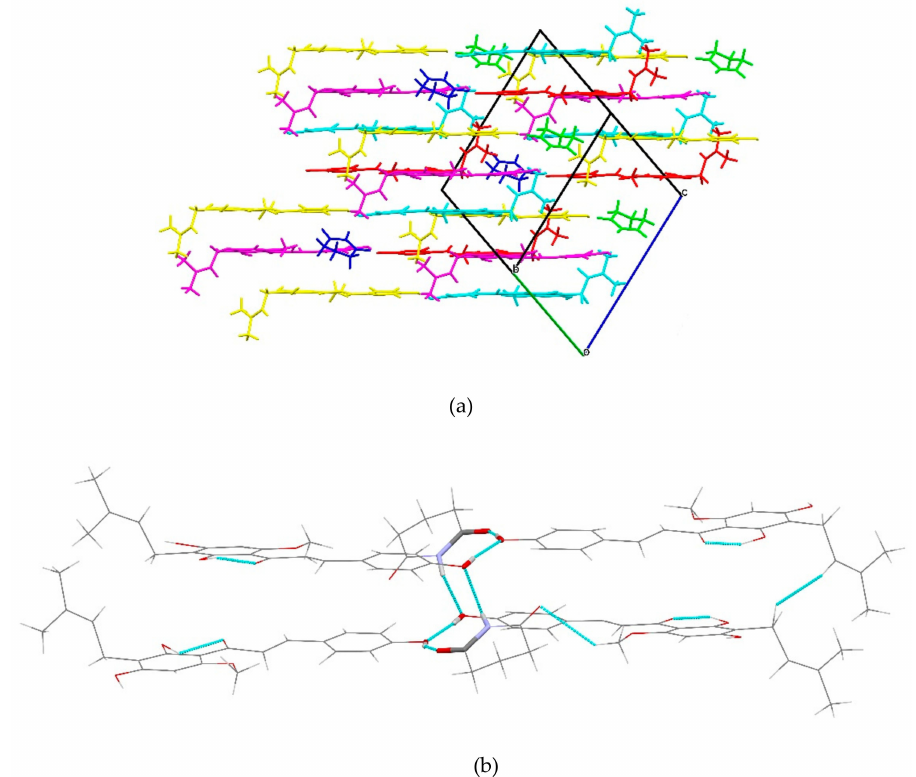
Figure 7. ( a ) Altered layers of AD, BC (yellow A, magenta D, red B and violet C) of XN molecules in XN − GA; ( b ) hydrogen bonds in a supramolecular ring structure, the graph set notation R 6 No symmetrically equivalent XN molecules in the crystal structure are represented by di ff erent